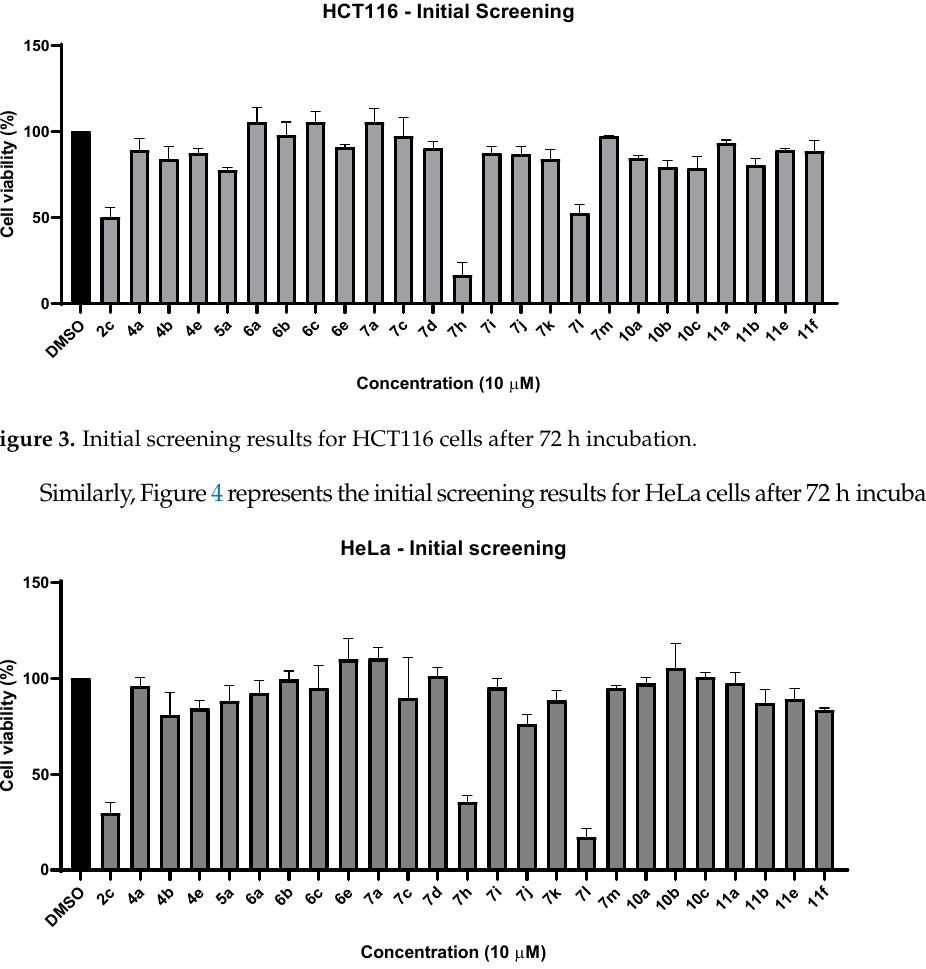
Table 1. IC 50 values of compounds in HCT116 and HeLa.